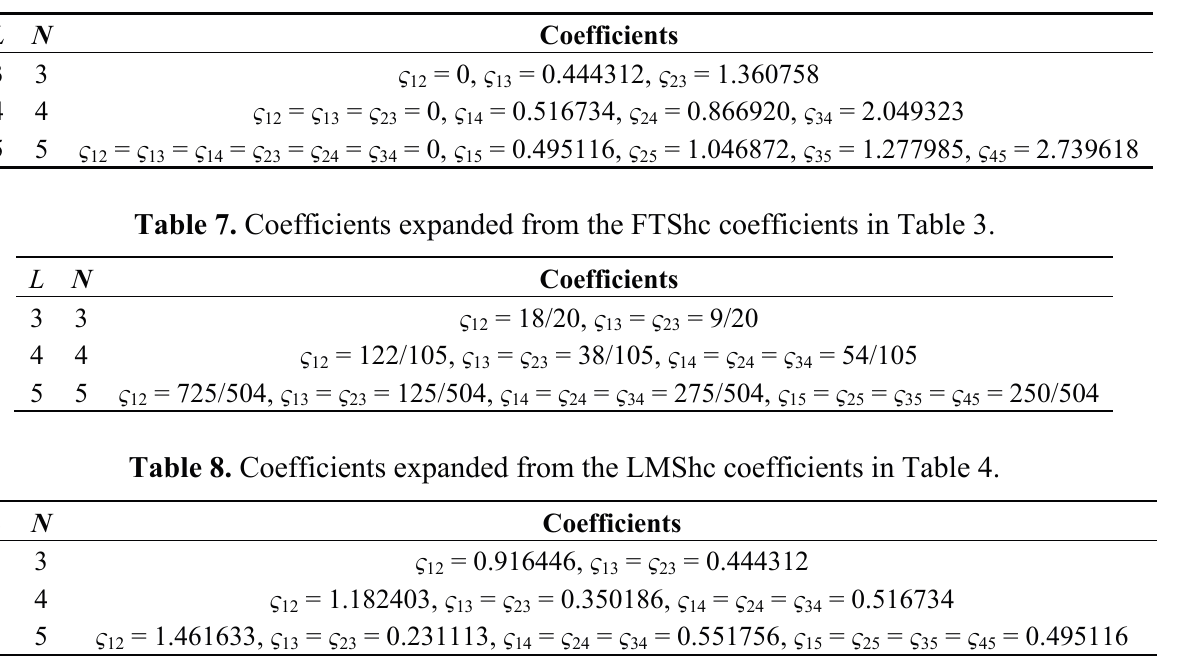
Table 6. Coefficients expanded from the LMSc coefficients in Table 2.